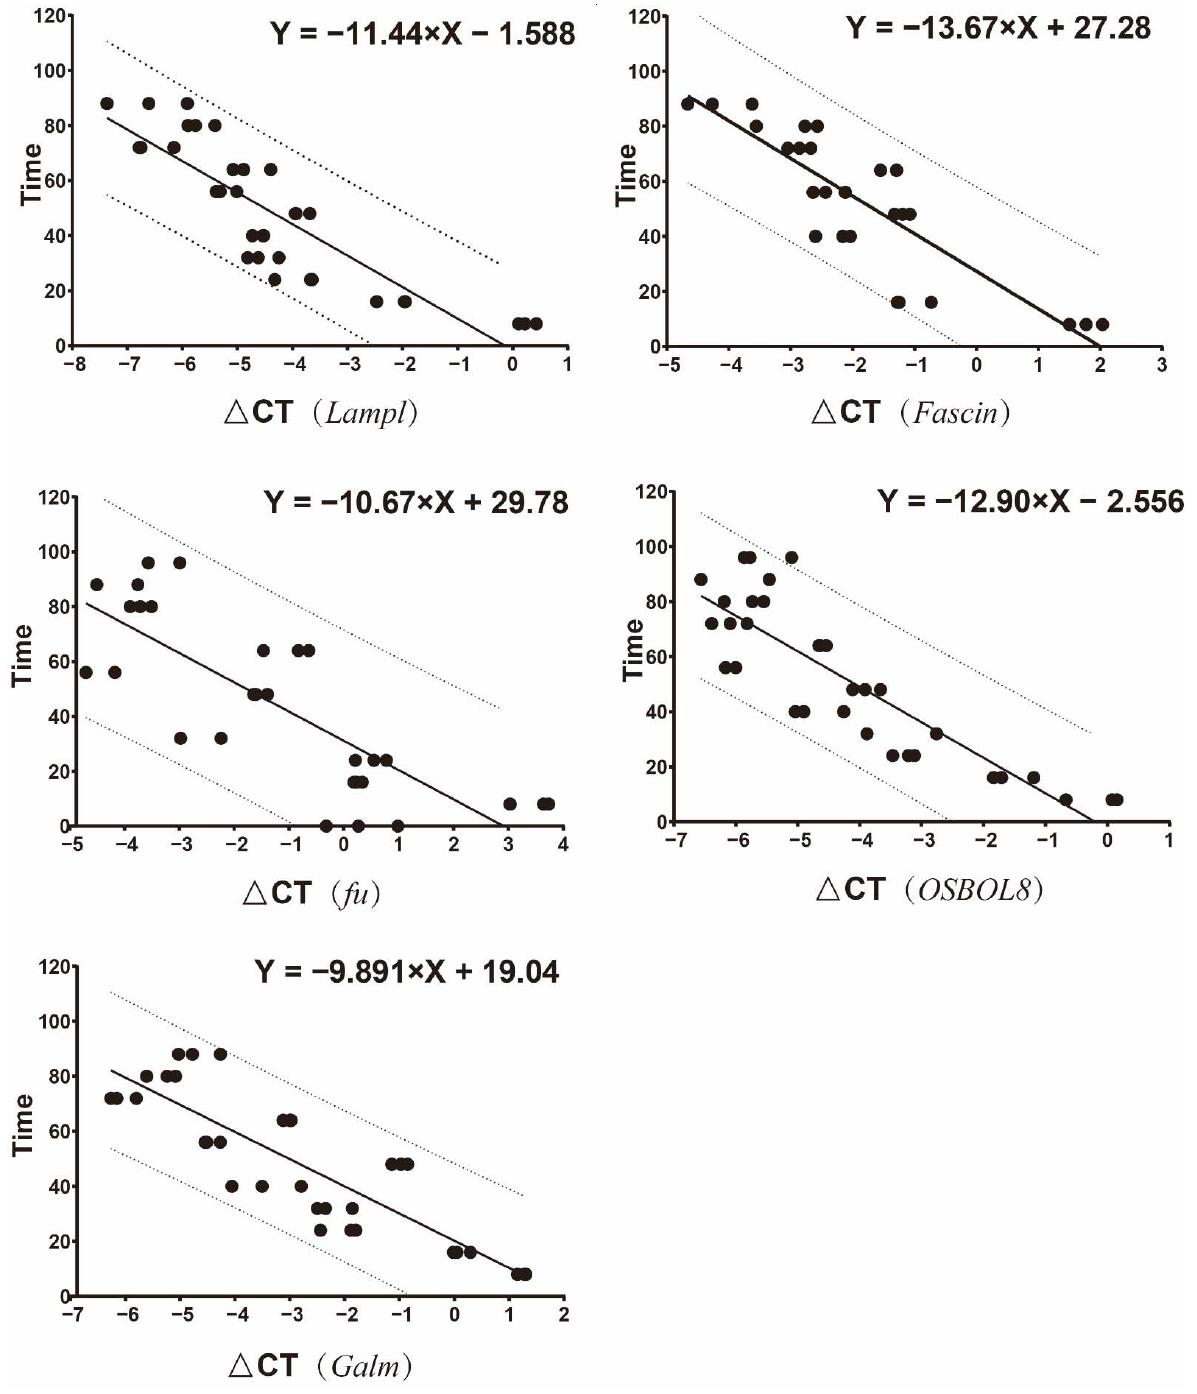
Figure 5. The linear regression equation between the relative expression levels of five target genes ( Fascin , Galm , Lamp1 , OSBPL8 , and fu ) and developmental time of larval stage. Y axis: sampling time (h); X axis: cycle threshold (CT) values of the target genes–the internal reference genes. The solid line is the linear regression equation, which denotes the predicted versus true development time, and the dotted lines denote predictions within 10% of true.